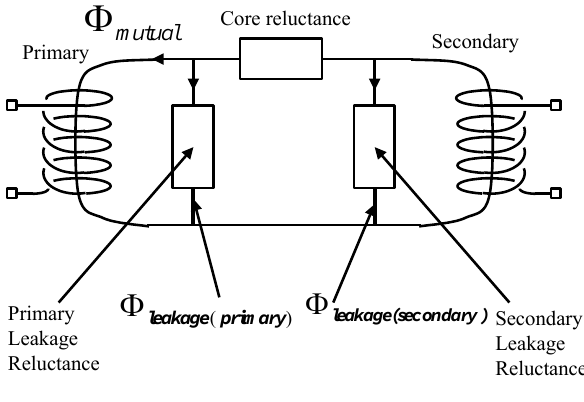
Figure 10: Electro-Magnetic Transformer Model